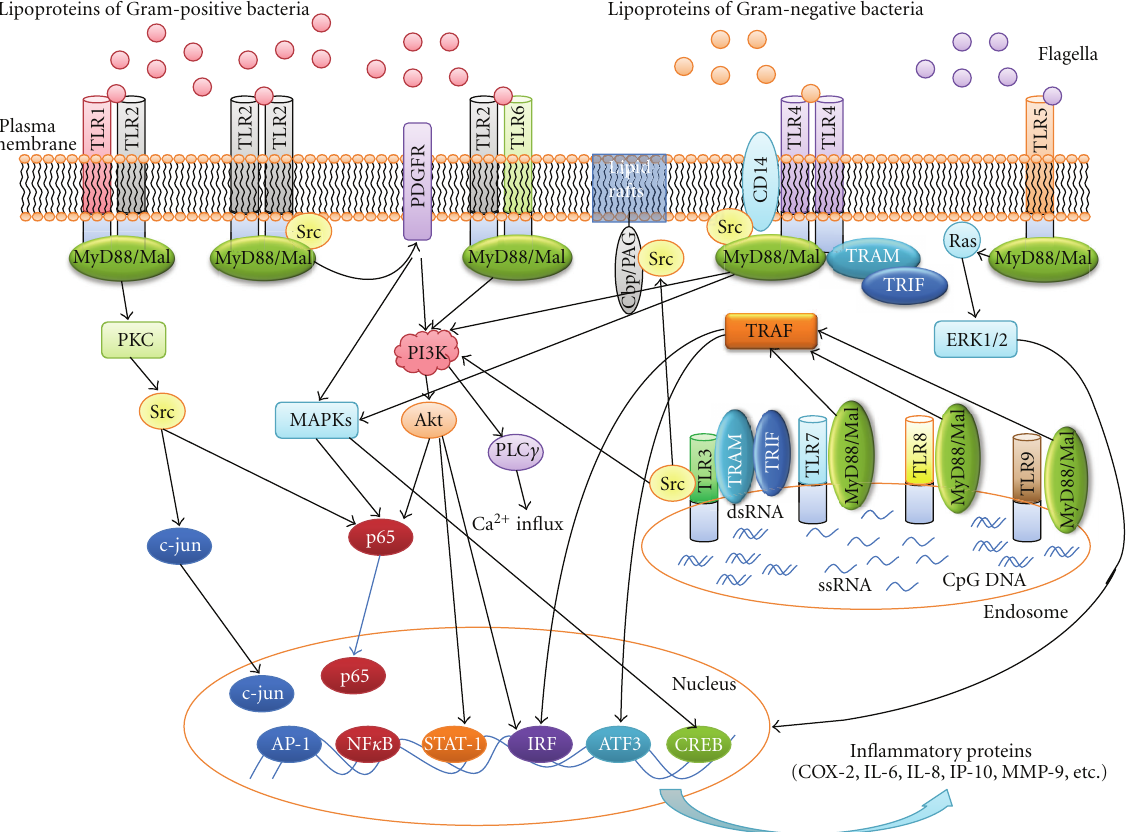
Figure 4: The Src-mediated signaling pathways in TLRs. In the TLR family signaling pathways, Src generally regulates the early steps of the signaling